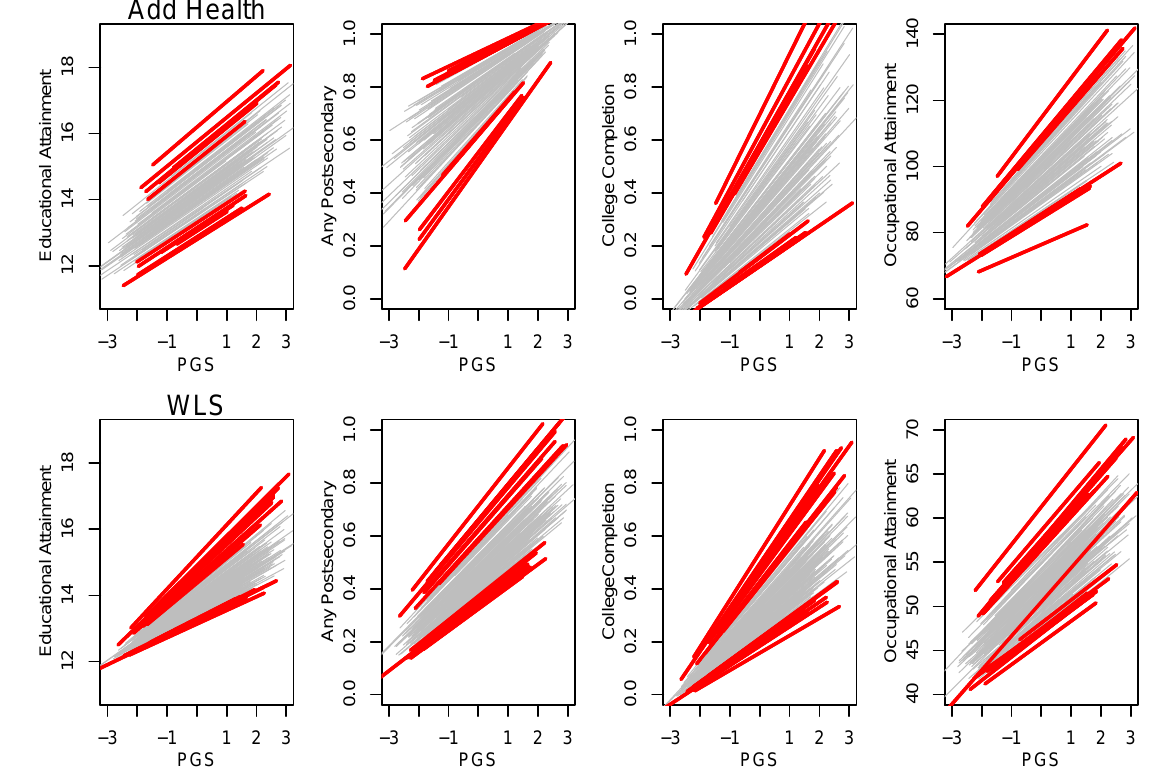
Figure 3: Prototypical plots for outcomes as a function of educational attainment PGS (for those schools with at least 10 respondents). Each line represents a school-level association between the PGS and the relevant outcome. Thick, red lines show the schools with slopes in the top and/or bottom 5 percent of the distribution of slopes in each panel. PGS, polygenic score; WLS, Wisconsin Longitudinal